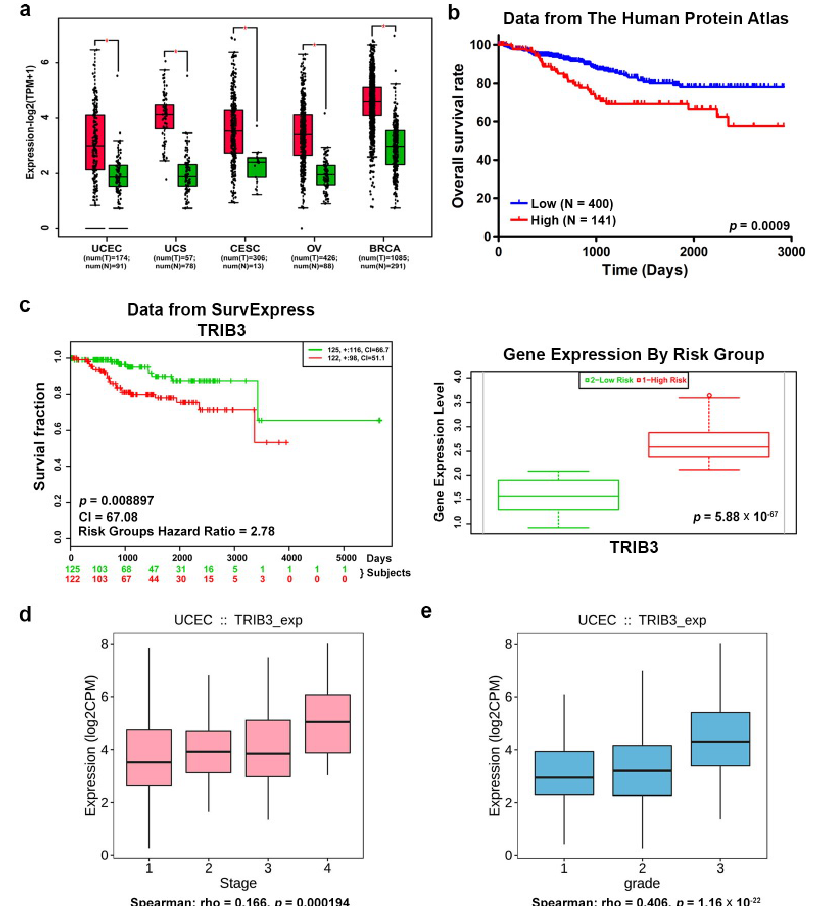
Figure 1. Tribbles pseudokinase 3 (TRIB3) expression is positively associated with shorter overall survivalofendometrialcancer(EC)patients.( a )TheTRIB3expressionlevelsamongcancerous(red color) and normal (green color) female tissues in The Cancer Genome Atlas (TCGA) database including uterine corpus endometrial carcinoma (UCEC), uterine carcinosarcoma (UCS), cervical squamous cell carcinoma and endocervical adenocarcinoma (CESC), ovarian serous cystadenocarcinoma (OV), and breast invasive carcinoma (BRCA) were analyzed and plotted using the Gene Expression Profiling Interactive Analysis (GEPIA) website. The cuto ff p -value was set to 0.01. ( b ) The correlation between TRIB3 expression and overall survival of UCEC patients in TCGA database was analyzed using the Kaplan–Meier plotter from the Human Protein Atlas. ( c ) The correlation between TRIB3 and overall survival of UCEC patients was also analyzed using the SurvExpress website. The red box and green box in the right panel represent the high-risk group and low-risk group, respectively. ( d , e ) The correlations of TRIB3 expression with clinical stages ( d ) and histology grades ( e ) of the UCEC dataset in TCGA database were analyzed using the TISDB